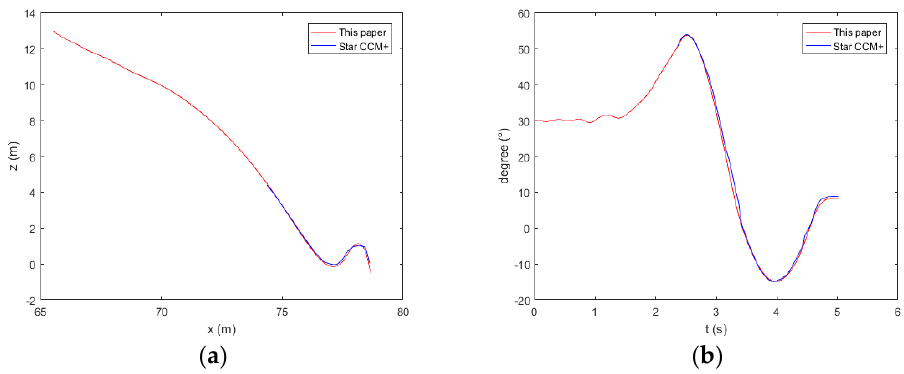
Figure 7. Trajectory ( a ) and pitch ( b ) of the lifeboat freefall during its launch from the ship.